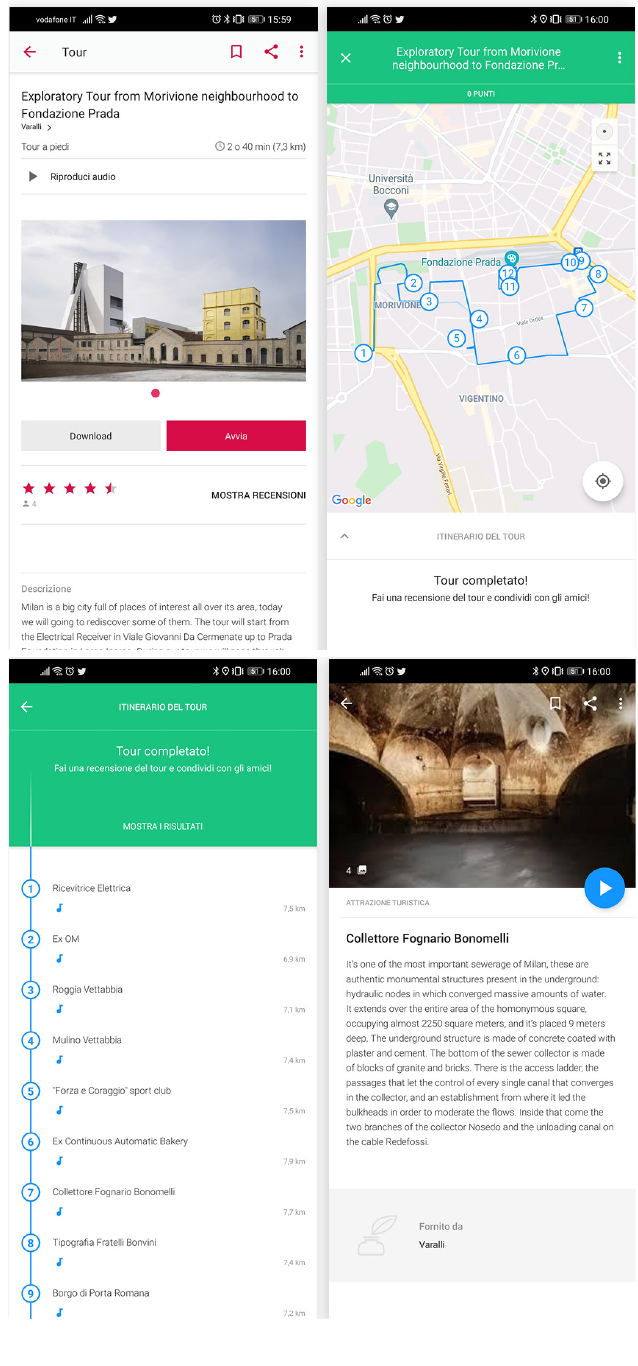
Fig. 10 Screenshots from the mobile guides developed by high-school